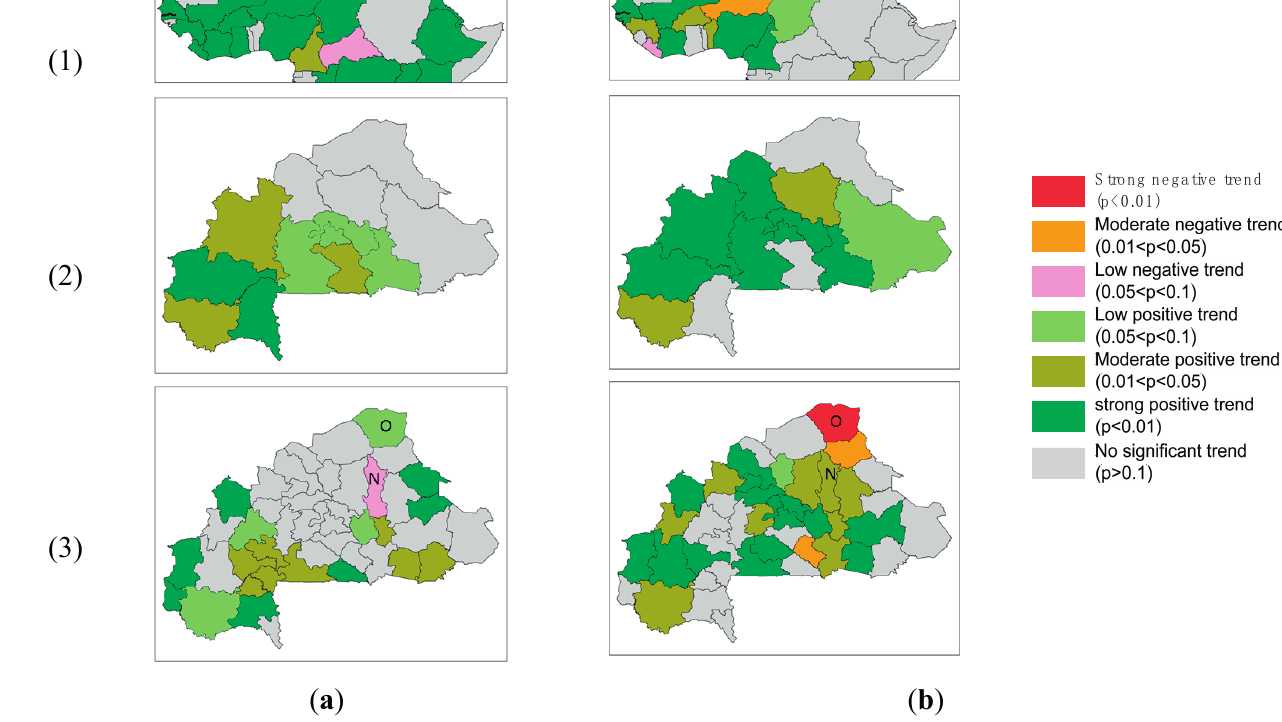
Figure 4. Comparison of FAOSTAT/AGRHYMET dynamics ( a ) and the MODIS LCP dynamics ( b ) of crop areas between 2001 and 2011 for ( 1 ) the national level (29 countries of Sub-Saharan Africa); ( 2 ) the 12 regions (level 1 below national) and ( 3 ) the 45 provinces (level 2 below national) of Burkina Faso. Positive dynamics are in green colors, negative dynamics are in red/pink colors and no significant dynamics are in grey. “O” and “N” represent the Oudalan and Namentenga